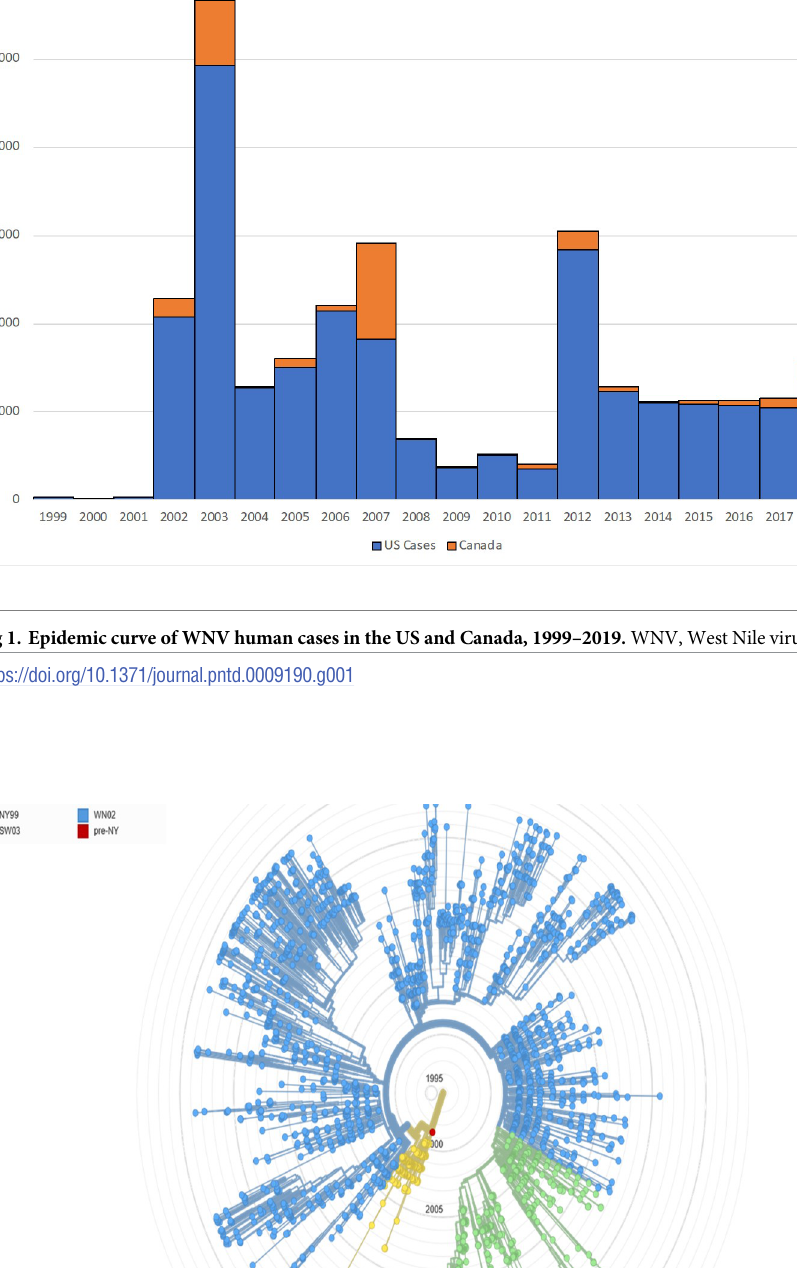
PLOS NeglectedTropical Diseases | https://doi.org/10.1371/journal.pntd.0009190 May 6,